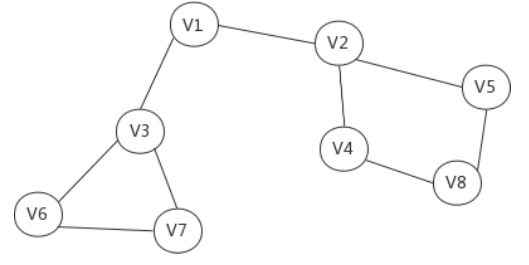
Figure 4. Undirected